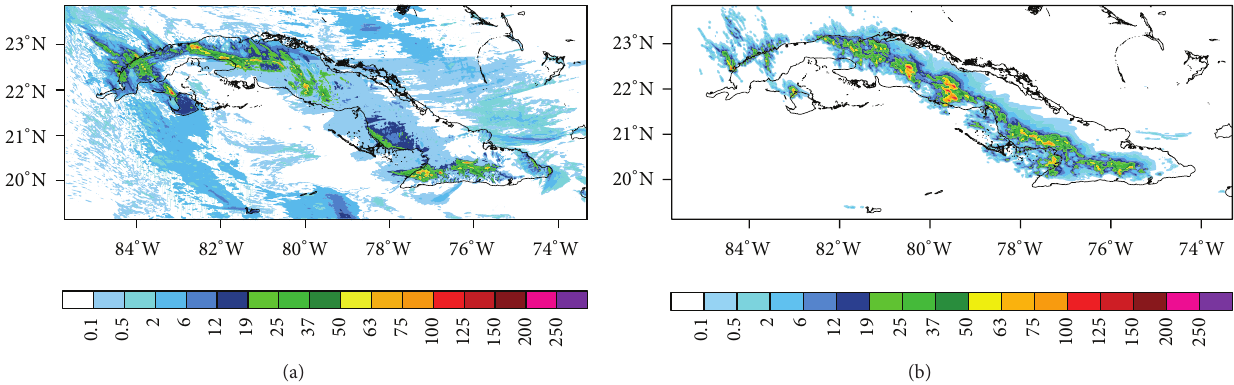
Figure 7: Six hours of cumulative precipitation (mm) valid for 0000 UTC, 2 May 2012. (a) Parameterized cumulus (KF M2m) and (b) explicit cumulus formation (Kfoff M2m).